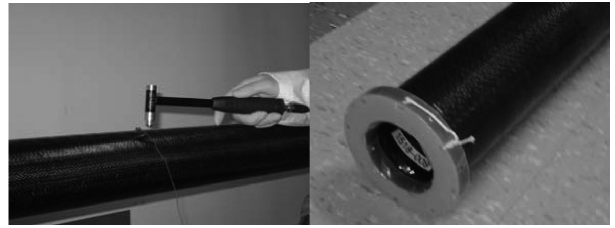
Fig. 4. Carbon fi ber in fl atable rigidized boom and the end mass made by ILC Dover.